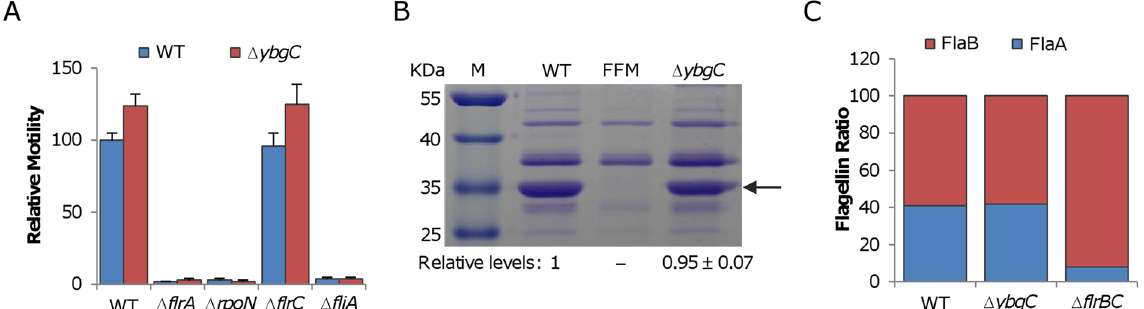
Figure 3. S. oneidensis ybgC mutant assembles a normal flagellum. ( A ) The ybgC mutation did not interfere with regulation of flagellar assembly. Four regulators were under test. Please note that FlrC is not essential to flagellar assembly in S. oneidensis . ( B ) Estimation of the flagellar length with SDS-PAGE analysis of isolated flagellins, whose levels are proportional to flagellar filament length. Flagellins from the same volume of mid-log phase cultures (adjusted to the same optical density) were extracted and separated on SDS-PAGE. The band intensity was estimated by using ImageJ. Relative flagellin levels were calculated by normalizing to the average level of WT, which was set to 1 for presentation. ( C ) Estimation of ratio of flagellin FlaA to FlaB with LC-MS/ MS analysis of flagellins obtained in B. Aliquots of flagellins were trypsin-digested and analyzed by LC-MS/MS to determine relative abundance of flagellins FlaA and FlaB. All experiments were performed at least three times with either representative results shown or with SEM presented as error bars.